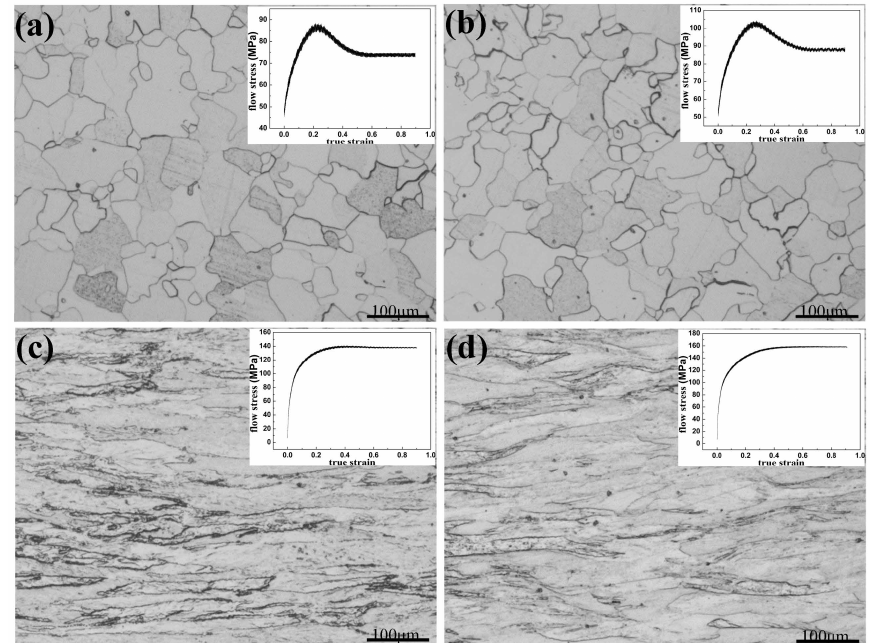
. Figure 2. Microstructure of Armco-type pure iron deformed at different conditions: ( a ) ε = 1s − 1 , . . . T = 1423K; ( b ) ε = 1s − 1 , T = 1373K; ( c ) ε = 1s − 1 , T = 1023K; and ( d ) ε = 1s − 1 , T = 973K. ( a , b ) relate to the completed DRX process in the hot deformation, while ( c , d ) relate to the DRV process with the deformation temperature lower than that of the hot deformation. The inserted figures are the corresponding true stress- strain